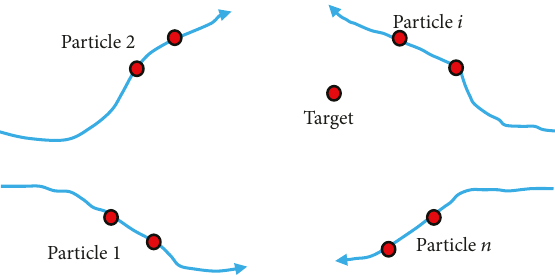
Figure 6: The basic principle of particle swarm optimization.